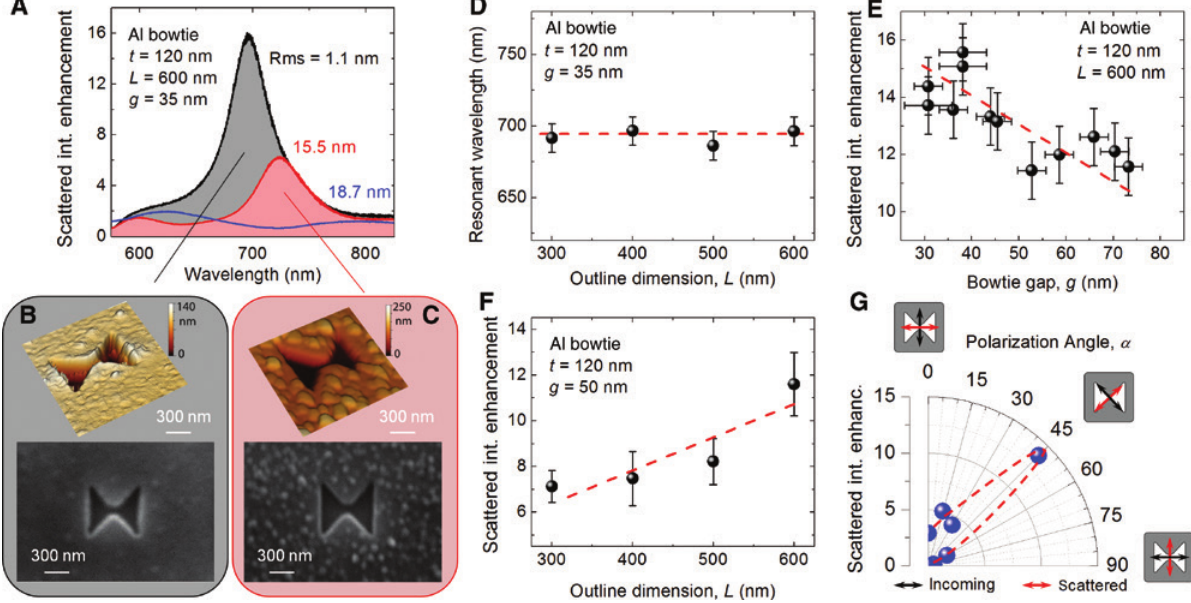
Figure 4: Bowtie NA optical